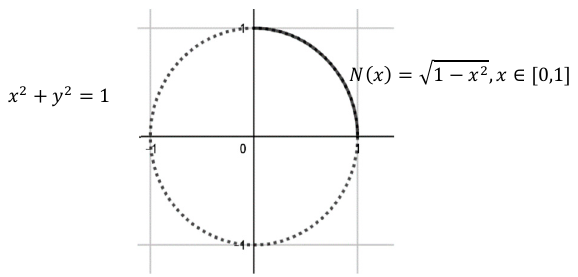
Figure 1. Strong negation via circle.